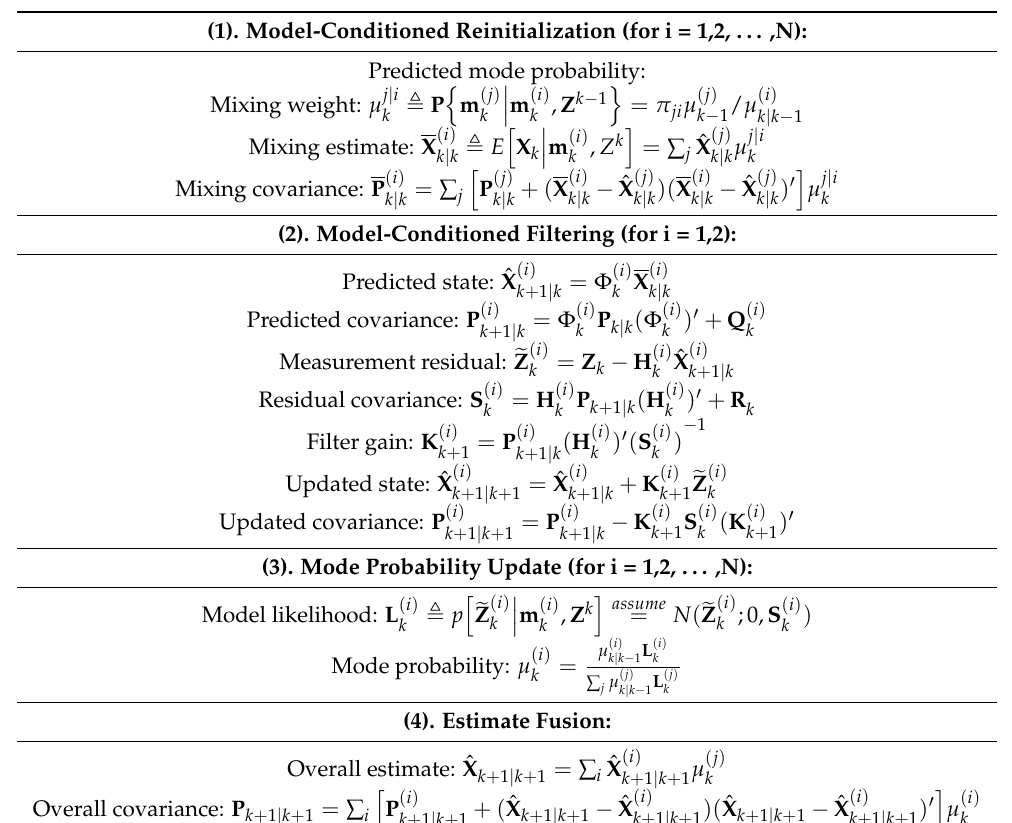
Table 1. One cycle of IMM